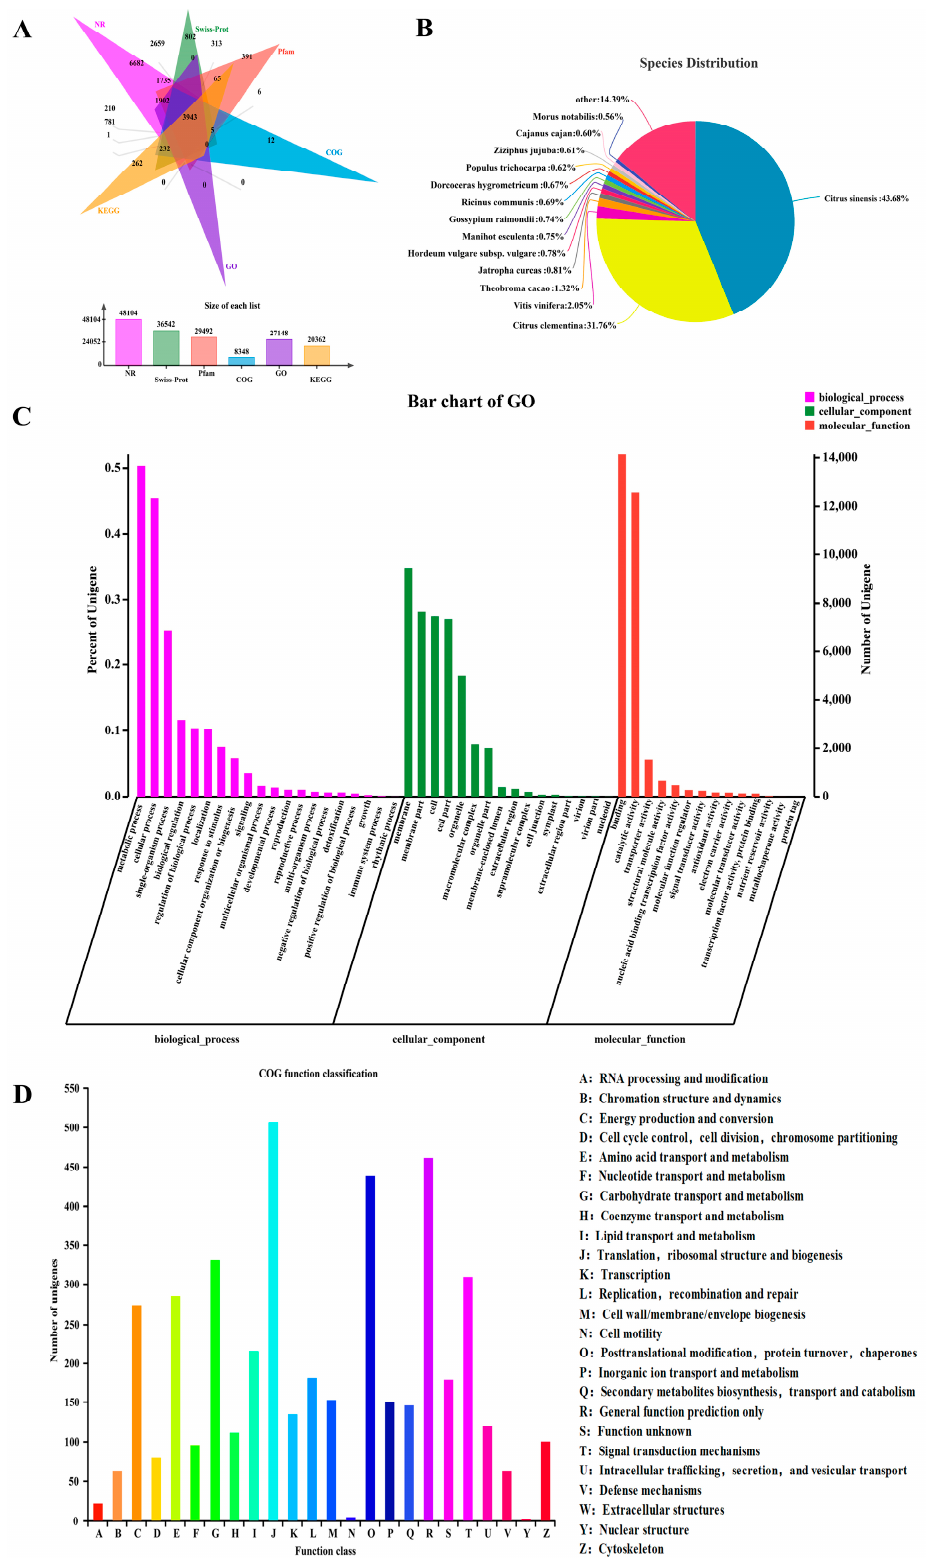
Figure 2. Functional annotation and classification of Z. armatum unigenes. ( A ) The number of unigenes with annotated information; ( B ) species distribution of the BLAST results of Z. armatum transcriptome. The numbers in the pies indicate the percentage of di ff erence in each category; ( C ) histogram of GO classification; ( D ) COG